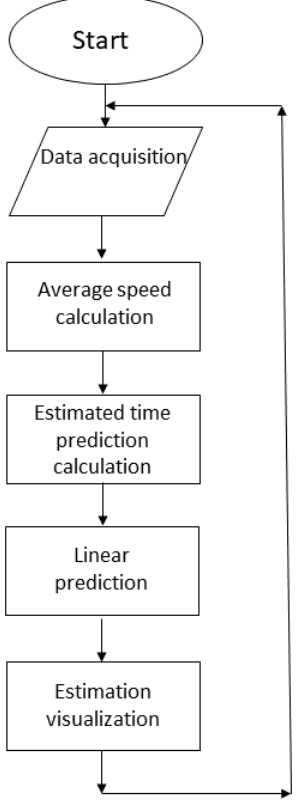
Figure 8. MAP prediction arrival time model flow diagram.